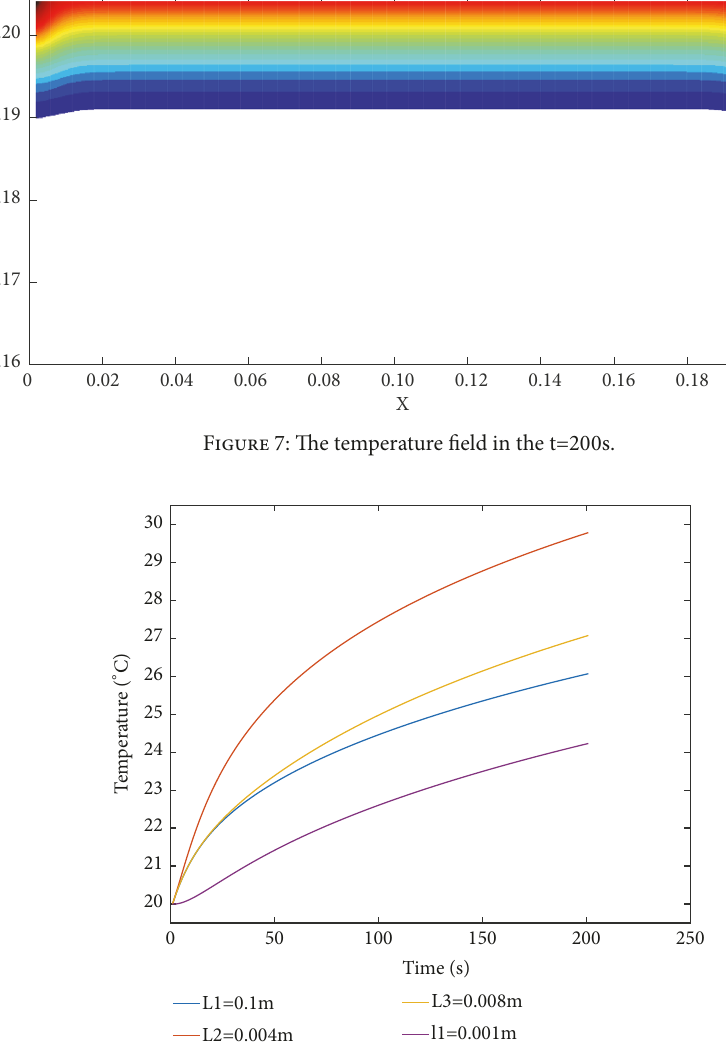
Figure 8: The curve of the measuring point with